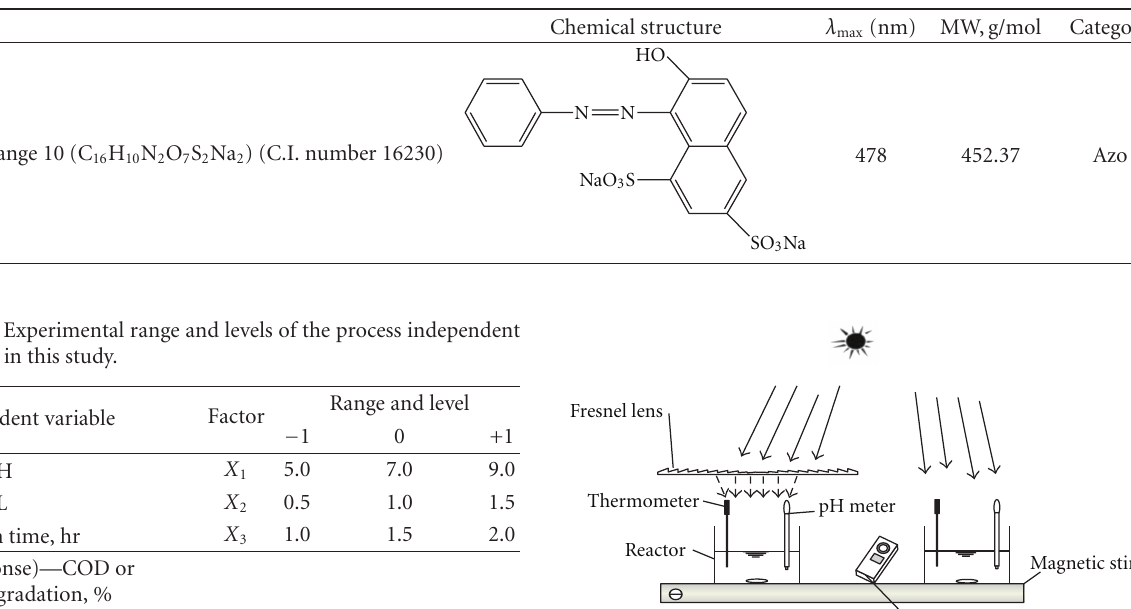
Table 1: Chemical characteristics of alizarin violet AO10.